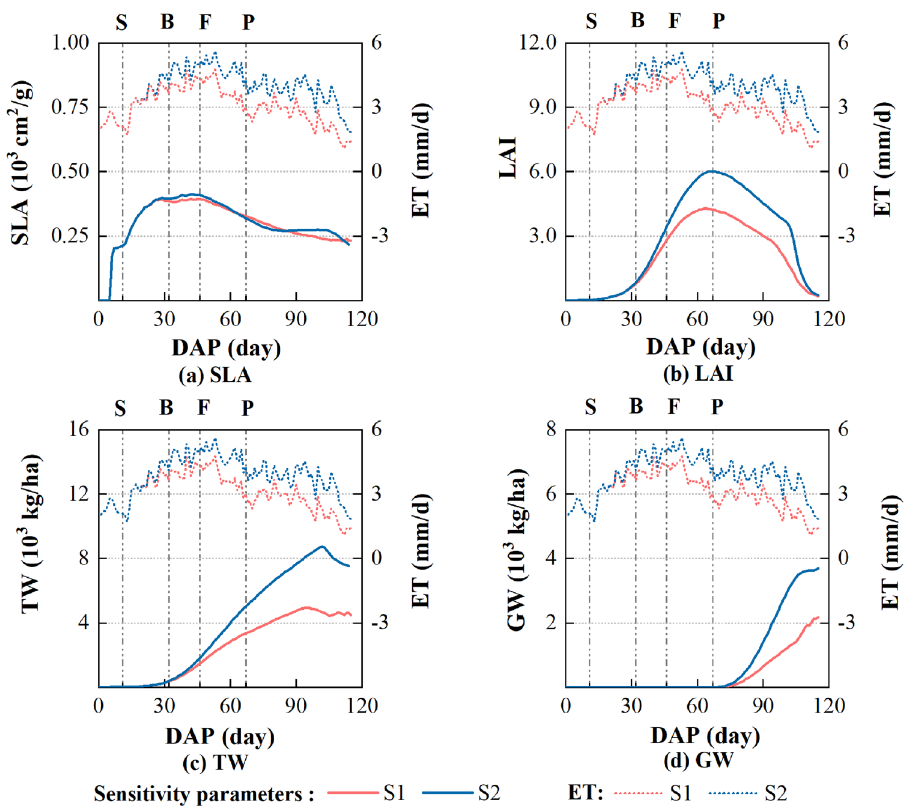
Fig. 4 Simulated daily average specific leaf area (SLA), evapo- transpiration (ET), tops weight (TW), and grain weight (GW) of soybean under the S1 and S2 scenarios in the Huaibei Plain study area in Anhui Province, China. Note: DAP = Day after Planting. S = Seedling stage; B = Branching stage; F = Flower- ing & pod-setting stage; P = Pod-filling